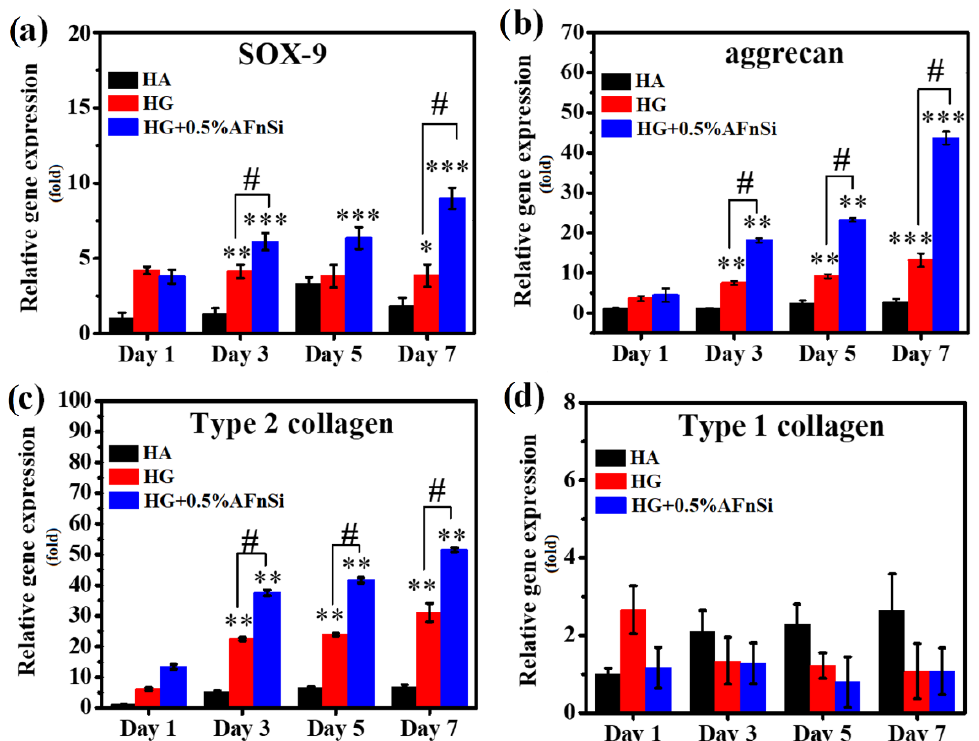
Figure 12. The related chondrogenic/osteogenic gene expression by RT-qPCR analysis in hADSCs were cultured with the photocured hybrid hydrogel of HG and HG+0.5% AFnSi on day 1, day 3, day 5, and day 7, respectively. Only the HA was controlled. Detection of chondrogenic marker gene expression of SOX-9 ( a ), aggrecan ( b ), type II collagen ( c ), and osteogenic marker gene expression of type I collagen ( d ). GAPDH was used as a housekeeping gene. Error bar represents ± SD, *** p < 0.001, ** p < 0.01, and * p < 0.05 compared to HA group, respectively. # p < 0.05 of HG+0.5% AFnSi compared to HG group.